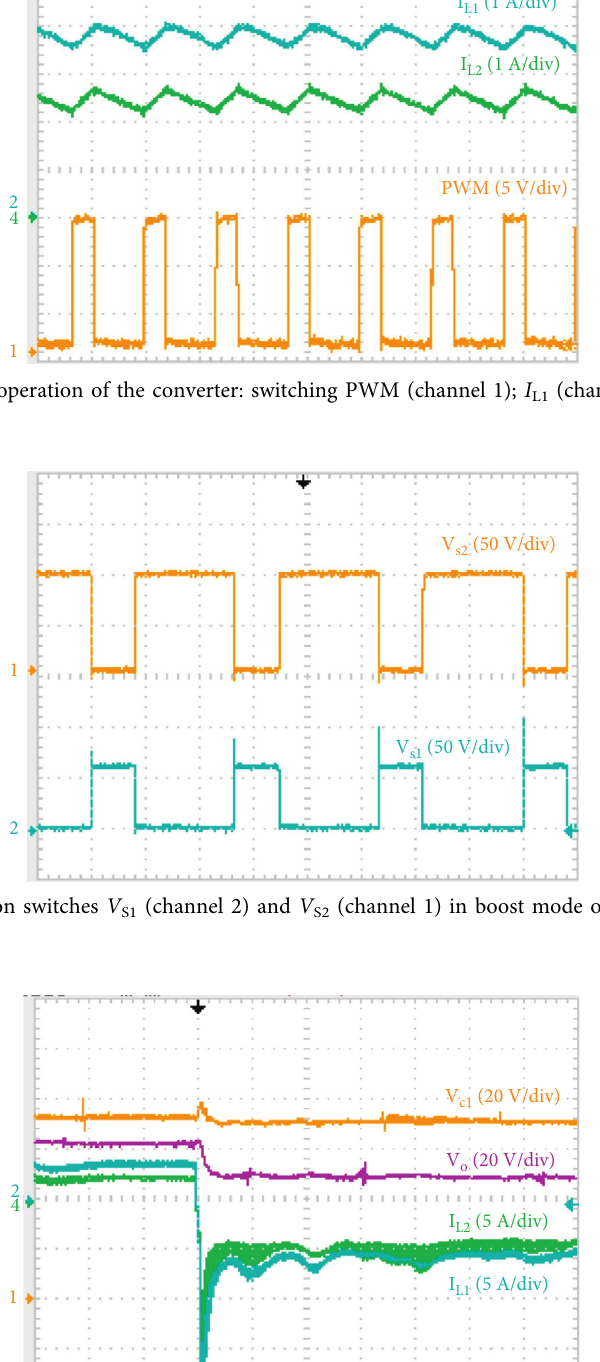
c1 (channel 1); I L1 (channel 2); V o (channel 3); I L2